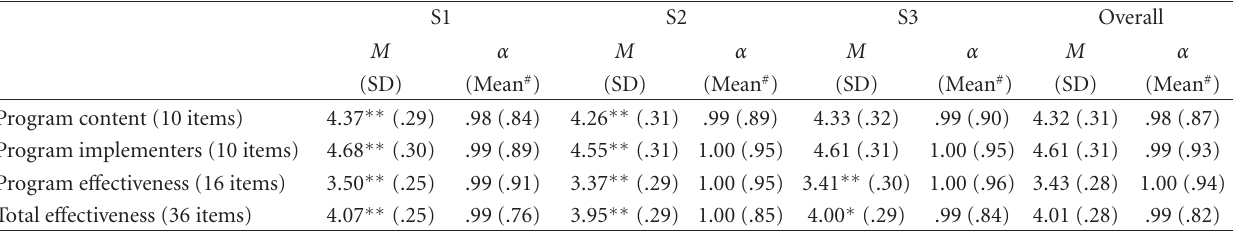
Table 5: Mean, standard deviations, Cronbach’s alphas, and mean of interitem correlations among the variables by grade.